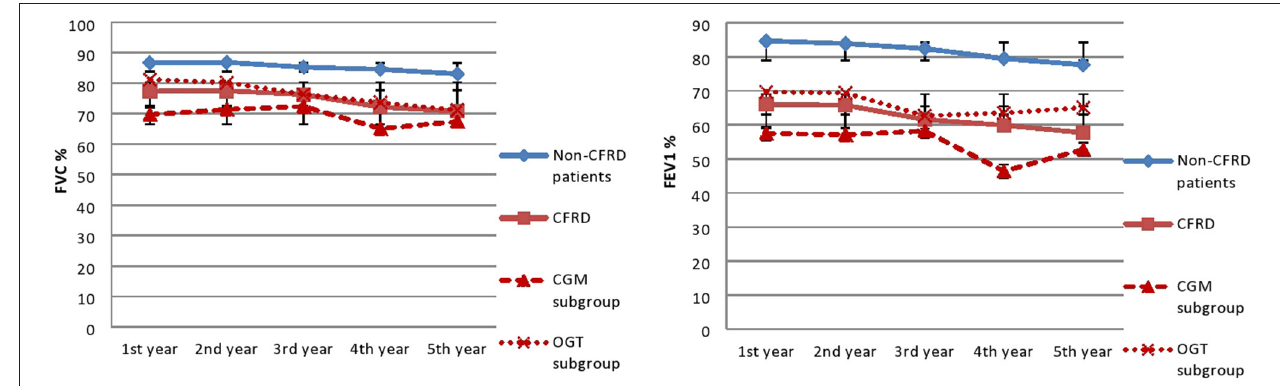
FIGURE 2 | Lung function trends. FVC, forced vital capacity; FEv 1 , Forced expiratory volume in 1s. In third year insulin therapy was started. There is a difference within each group during the observed period ( p < 0.001), no significant difference was observed between